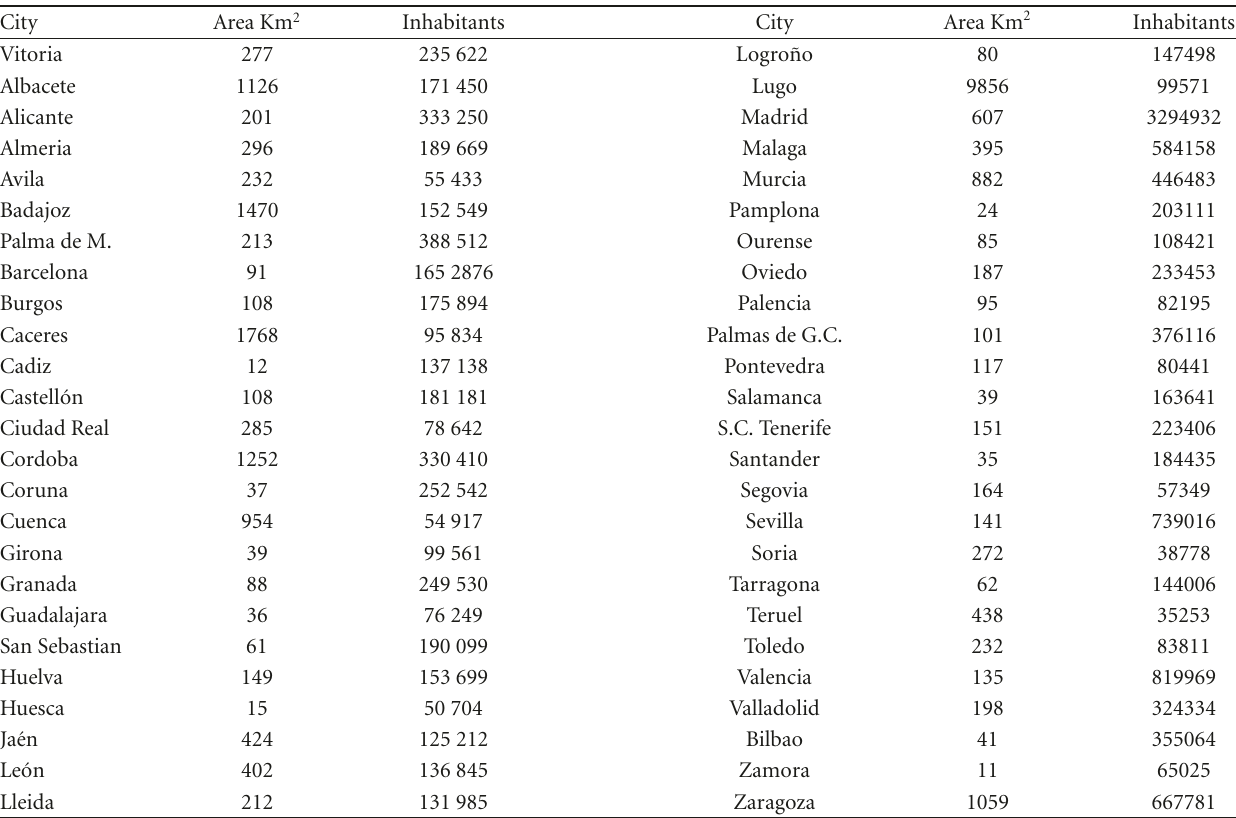
Table 12: Set of 50 cities considered in the scenario.